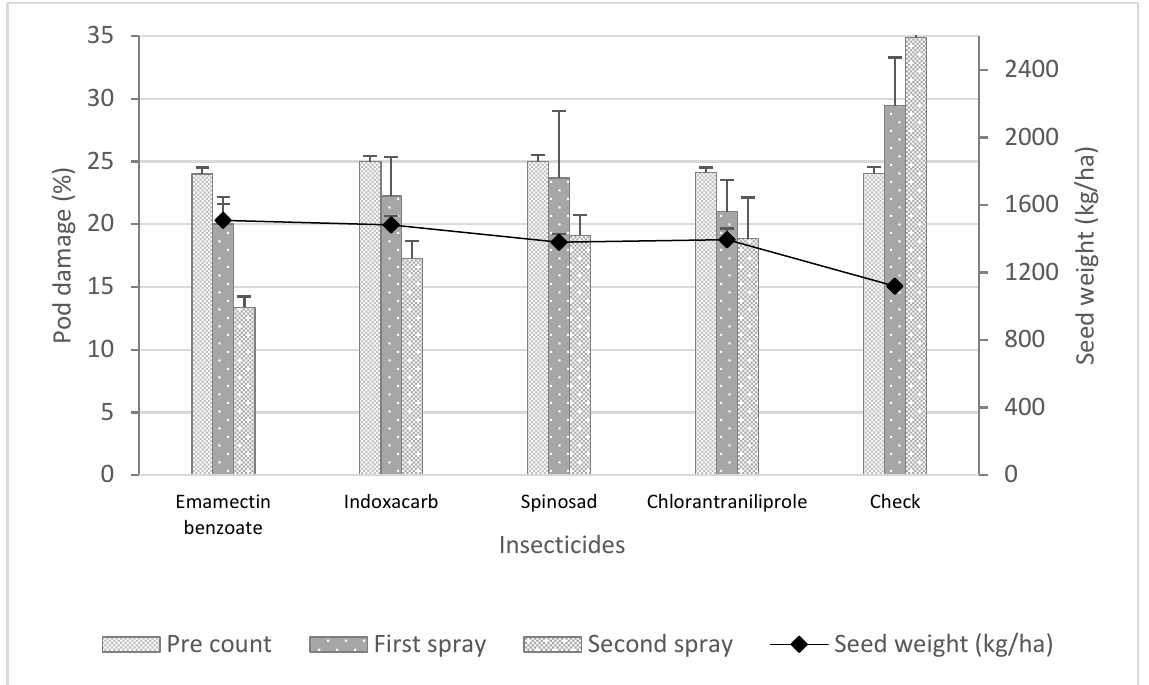
Figure 3. Effectiveness of different insecticides on the percentage of pod damage and yield of chickpea in Marchouch Station. 2017.